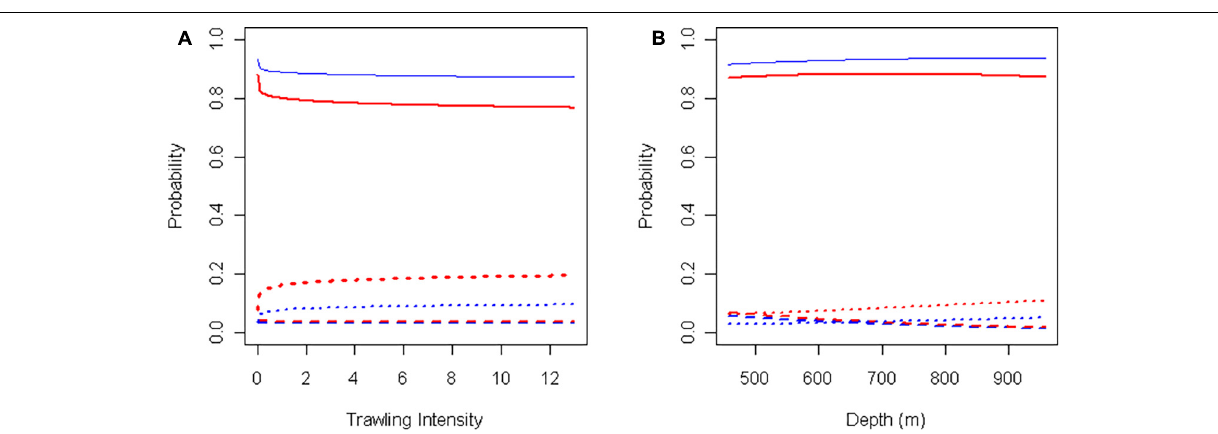
FIGURE 6 | Model predictions of the probability of intact (solid), tipped (dashed), or broken (dotted) Keratoisis grayi in Halibut Channel (blue) and Haddock Channel (red) in relation to (A) trawl intensity (depth = 650 m), and (B) depth (trawl intensity =